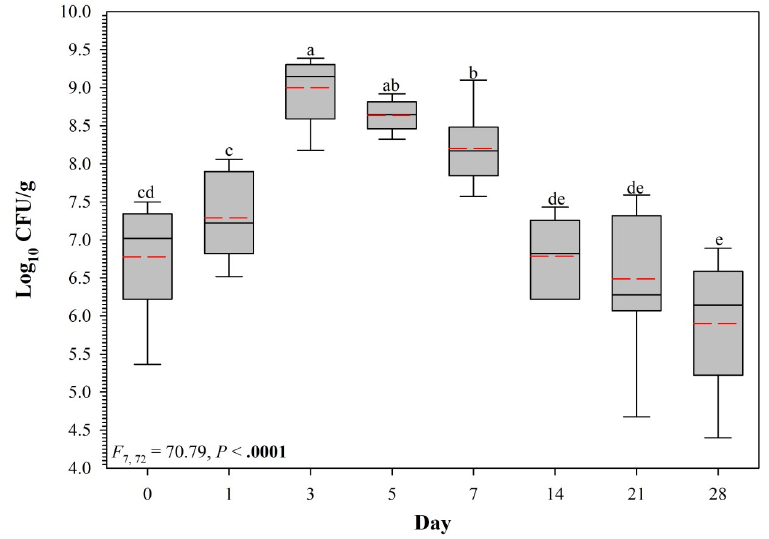
Figure 4. Persistence of virulent Aeromonas hydrophilia ML-09-119 population (log 10 CFU g −1 ) in soil samples collected from 12 study chambers (2 farms × 2 ponds/farm × 3 replicate tanks per pond). Within each box plot, solid black horizontal line indicates the median, dashed red horizontal line indicates the mean. Box plots with different lowercase letters are significantly different at p < 0.05.